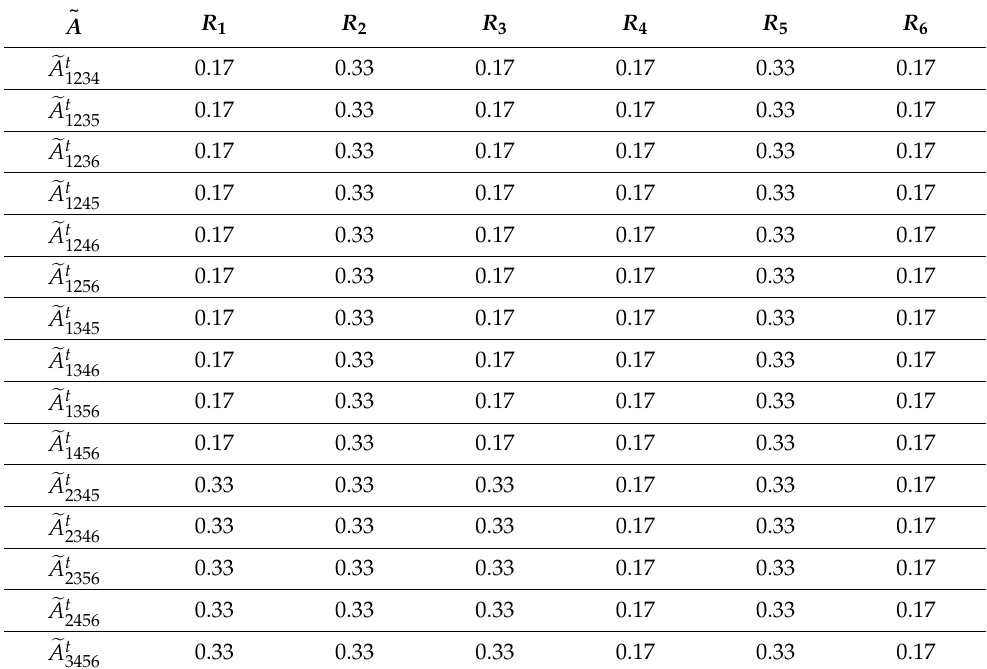
Table 3. Results of weight matrix calculation (cid:101) A .